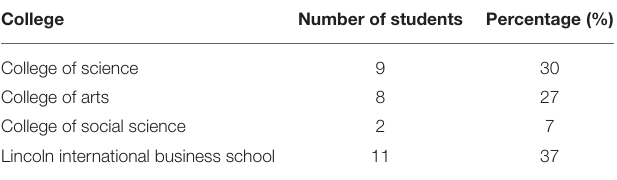
TABLE 1 | Number of students per college.